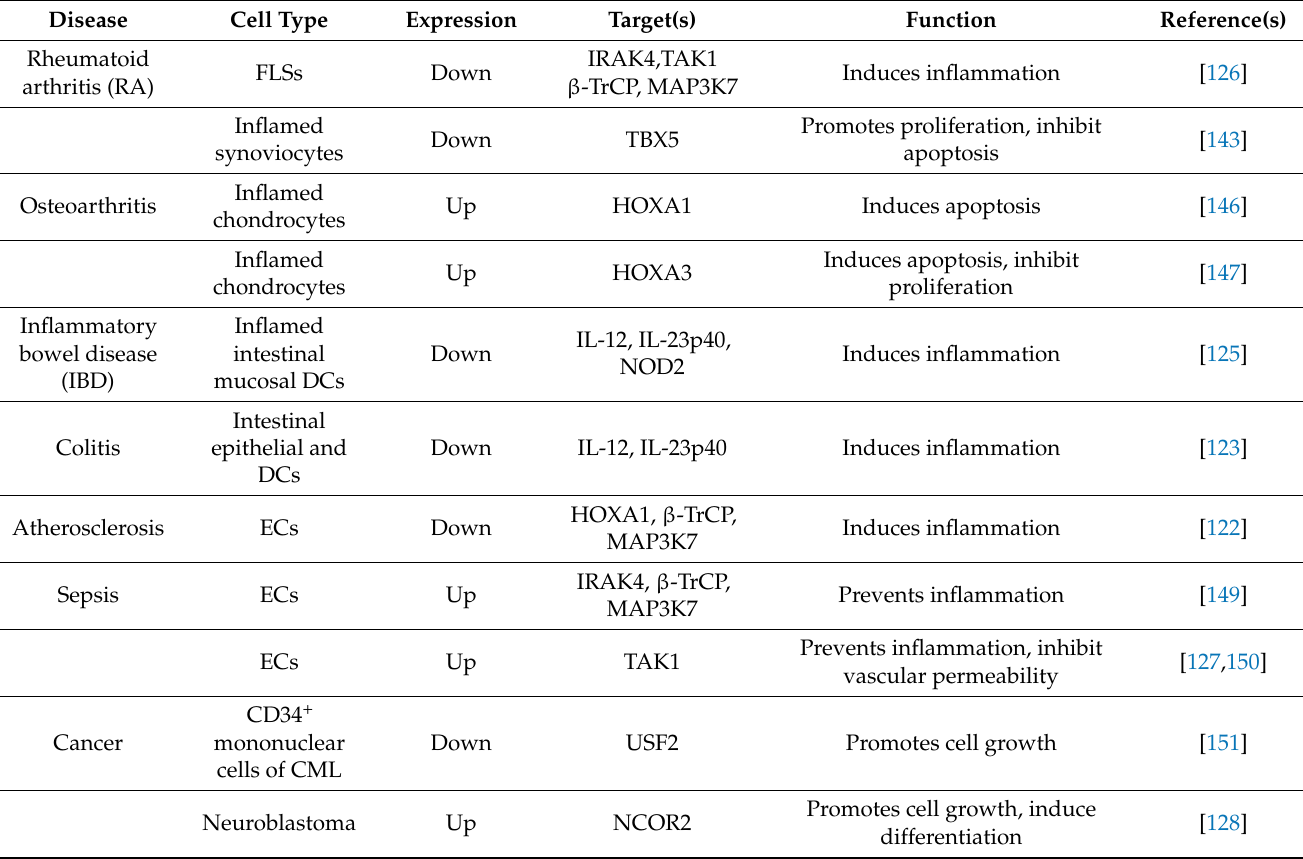
Table 4. The role of miR-10a in various inflammation-associated